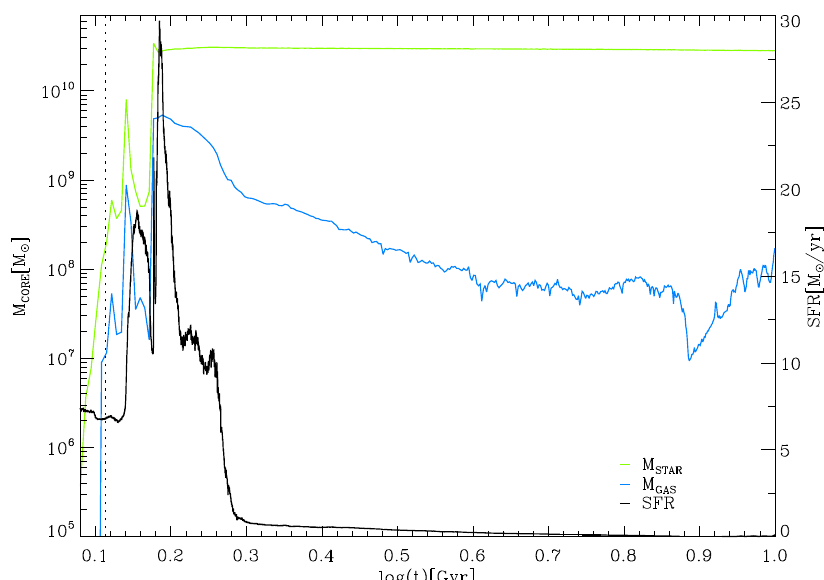
Figure 2. Temporal evolution of global core properties and the total star formation rate (SFR) of the complete galaxy. The black line indicates the SFR of the entire galaxy, while the green and blue curves represent the total stellar and gaseous mass within the KDC, respectively. The vertical dashed line marks the moment of the second